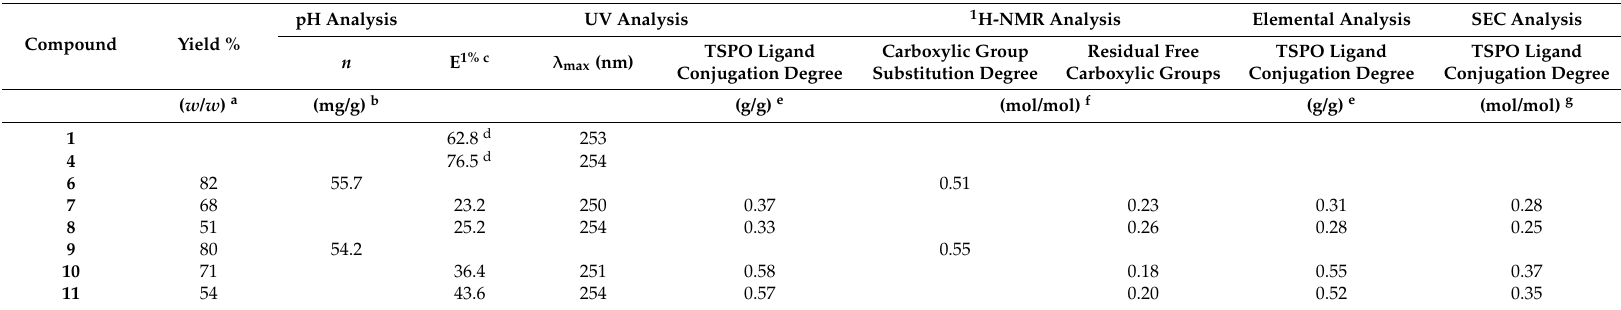
Table 2. Yield, acid number ( n ) and carboxylic group substitution degree of the carboxylated dextran derivatives 6 and 9 and conjugation degrees of TSPO ligand conjugates 7 , 8 , 10 and 11